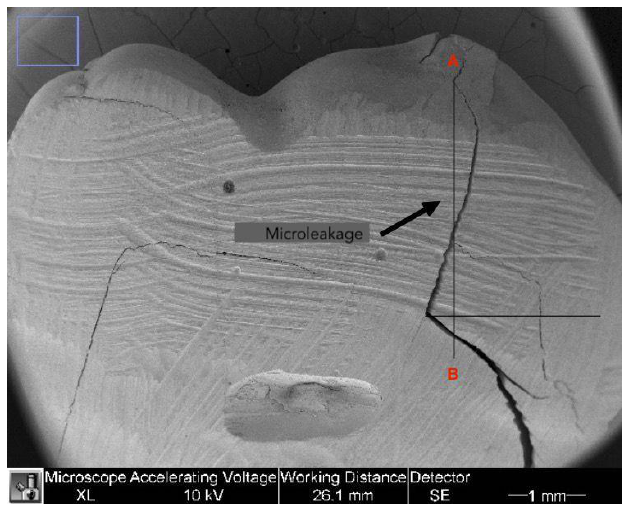
Figure 1. The distance between point A and point B on the 40× image.